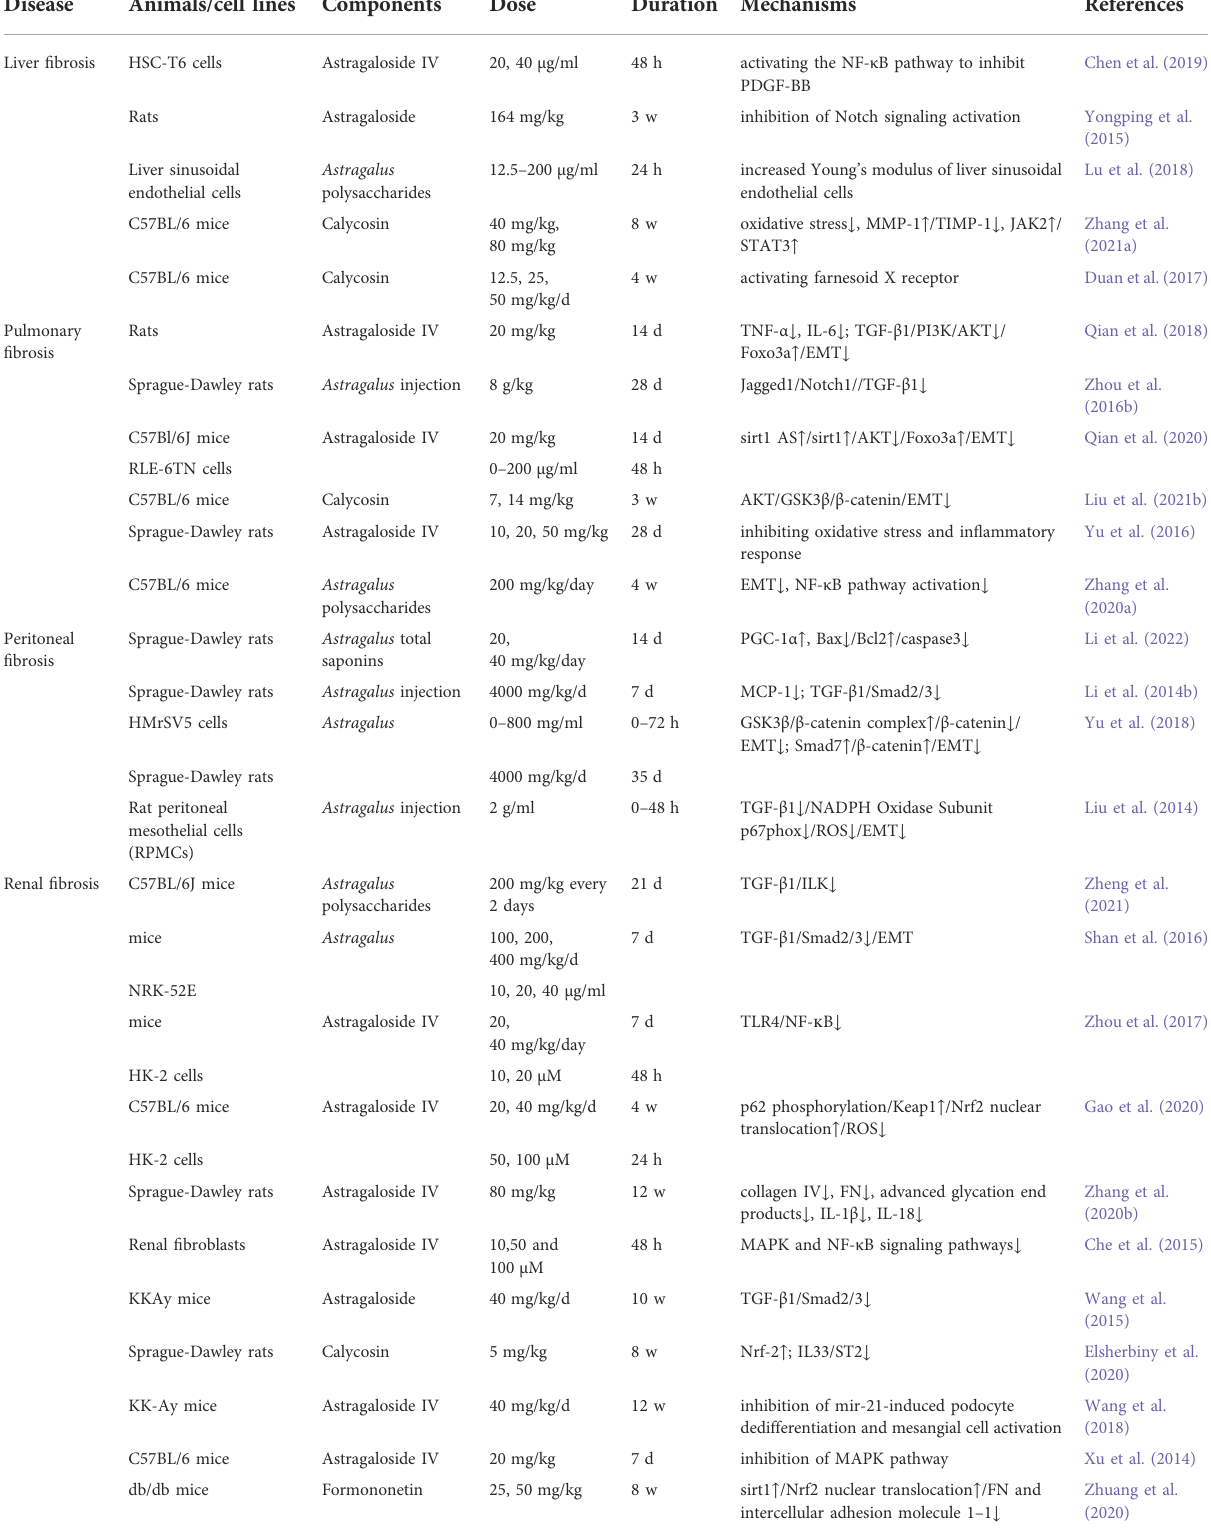
TABLE 1 Effect of Astragalus and its active components on fi brotic diseases.